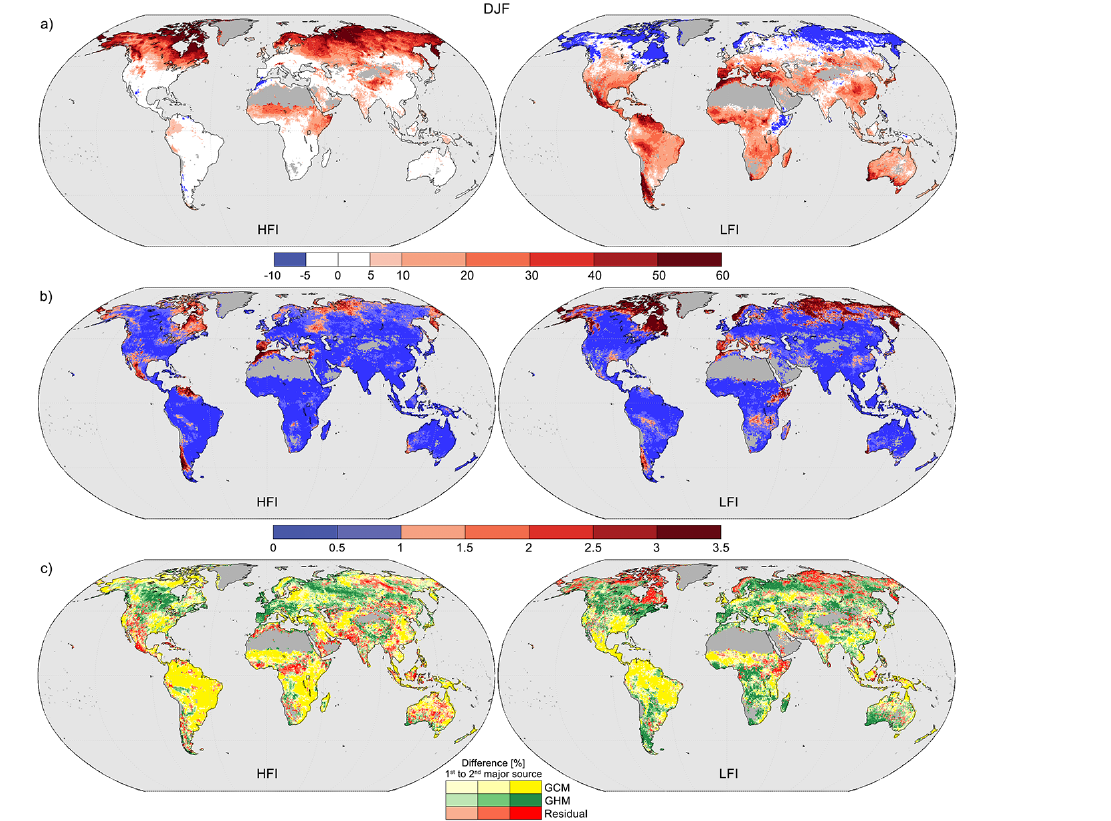
Figure 3. As Fig. 1, for the season